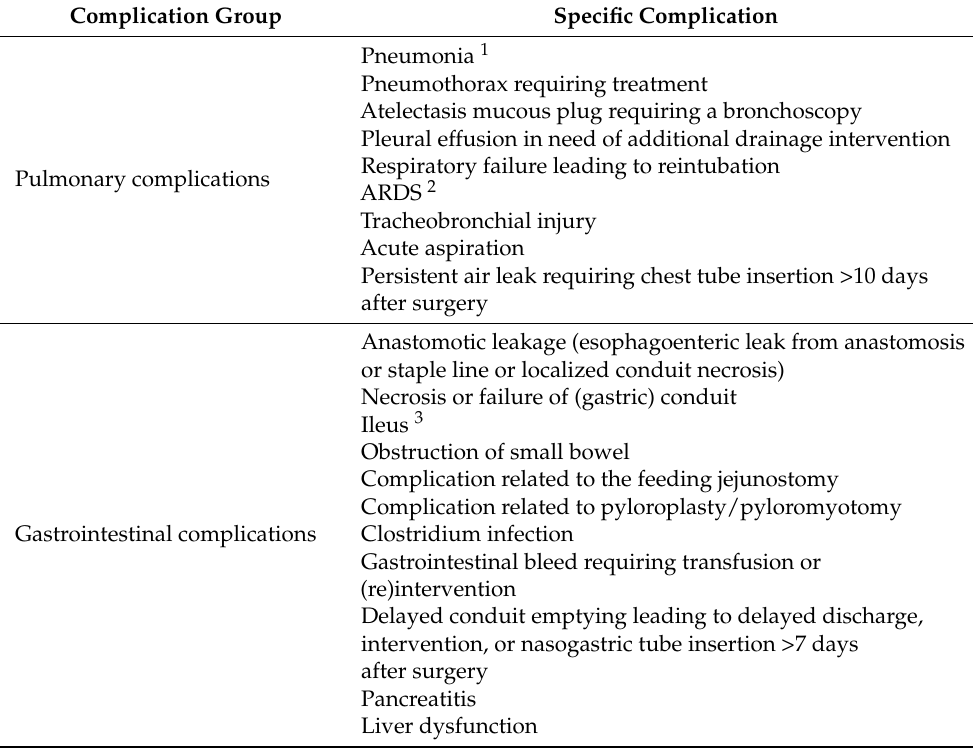
Table 1. ECCG complication set [76].